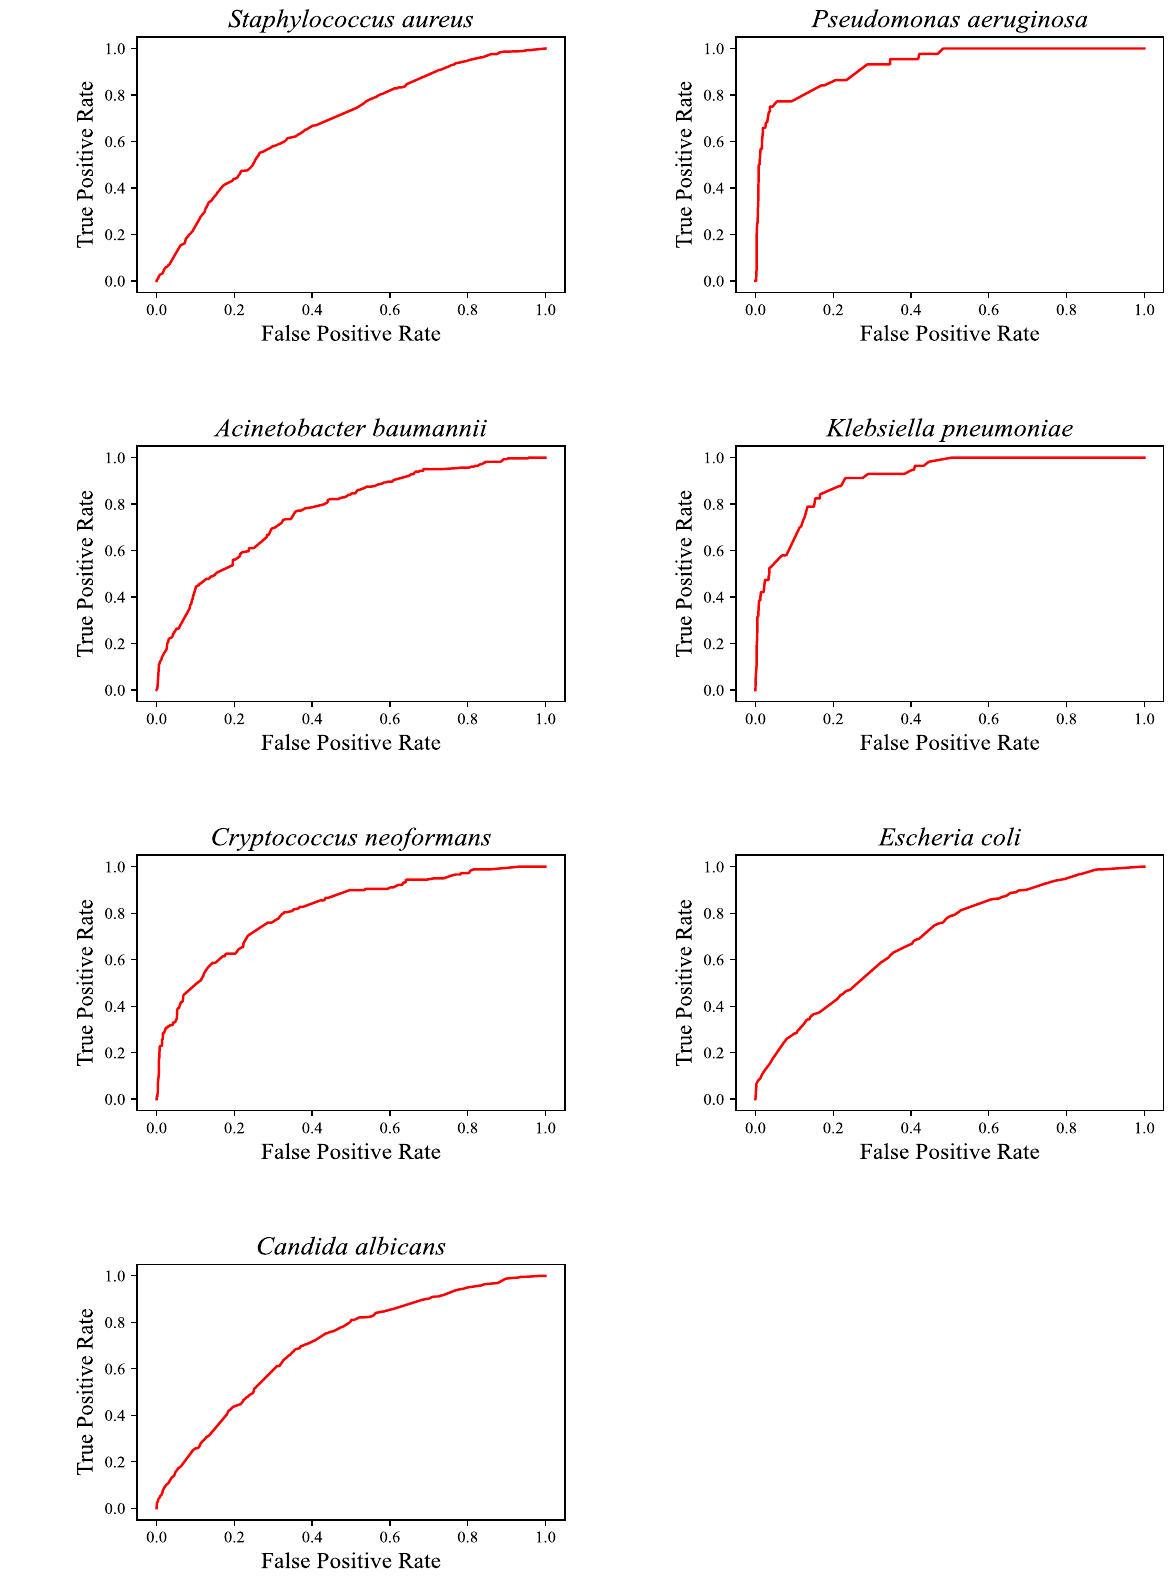
Figure 6. ROC curve of InterPred for prediction of growth inhibition for 7 different bacteria in the CO-ADD